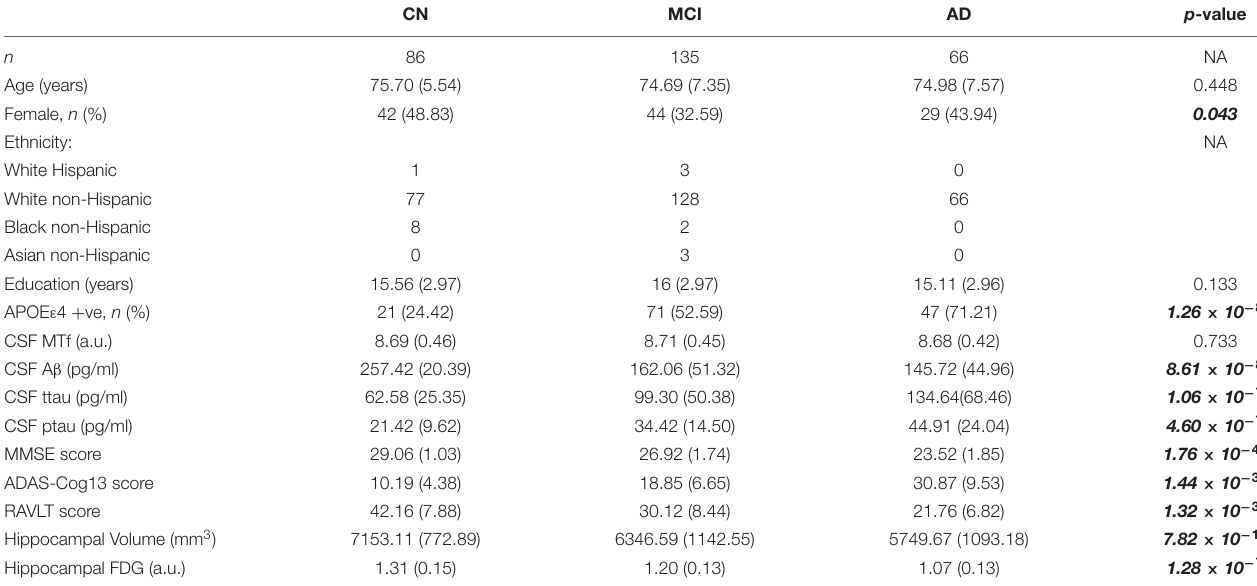
TABLE 1 | Demographics of subjects stratified by diagnosis: cognitively normal (CN), mild cognitive impairment (MCI), and Alzheimer’s disease (AD). CN MCI AD